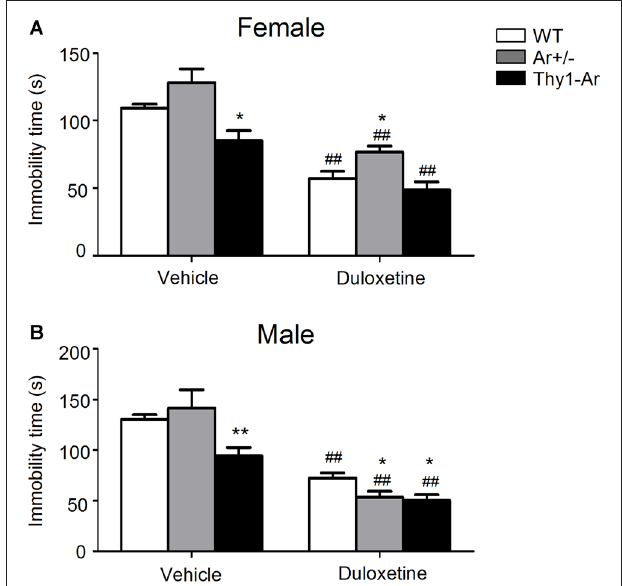
FIGURE 1 | Immobility time in the force swimming test (FST) of three genotype in both female and male mice treated by duloxetine. The immobility time in the FST of three genotype in female mice (A) and male mice (B) treated by duloxetine. ## Indicates P < 0.01 compared to vehicle-treated, ∗ indicate P < 0.05 and ∗∗ P < 0.01 compared to wildtype (WT) mice mice. n = 6–7 mice/group.